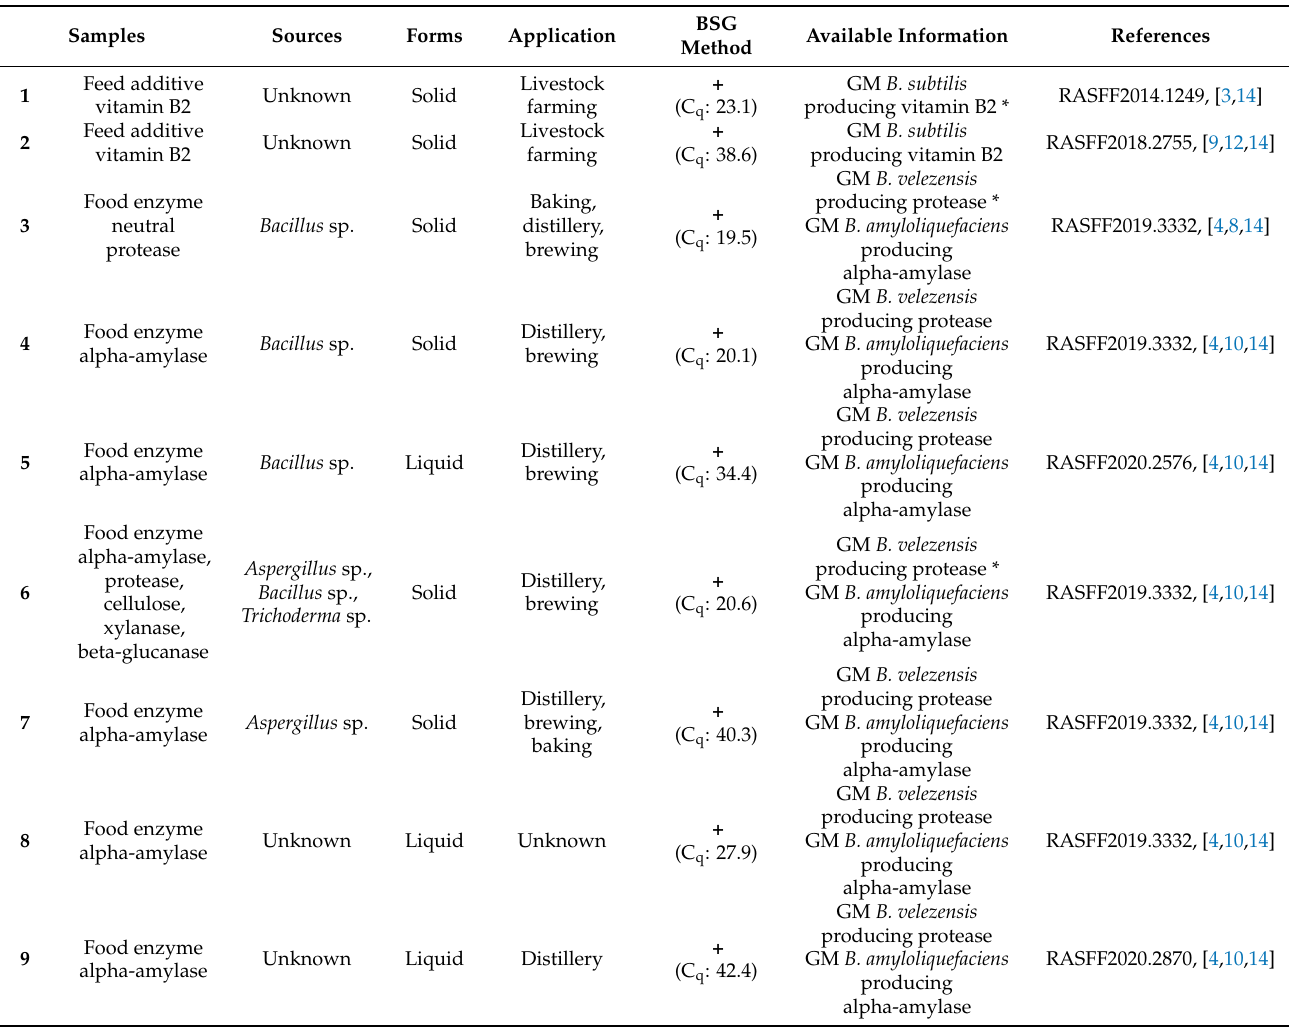
Table 4. Applicability assessment of the developed real-time PCR BSG method using commercialized microbial fermentation products. The BSG method was applied on 25 samples. For each sample, labelled information related to enzyme/additive microbial production sources, forms and application fields is indicated. Each sample was tested at a concentration of 10 ng in duplicate. The presence or absence of PCR amplification is symbolized by “+” or “ − “, respectively. The means of the observed C q are indicated in brackets. Available information related to previously reported contaminations (GMM, Bacterial DNA) is also indicated for each sample. * Successful isolation of the GMM strain previously